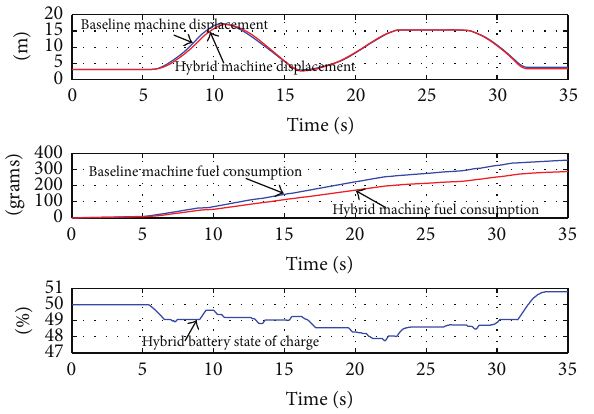
Figure 16: Short load and carry cycle.